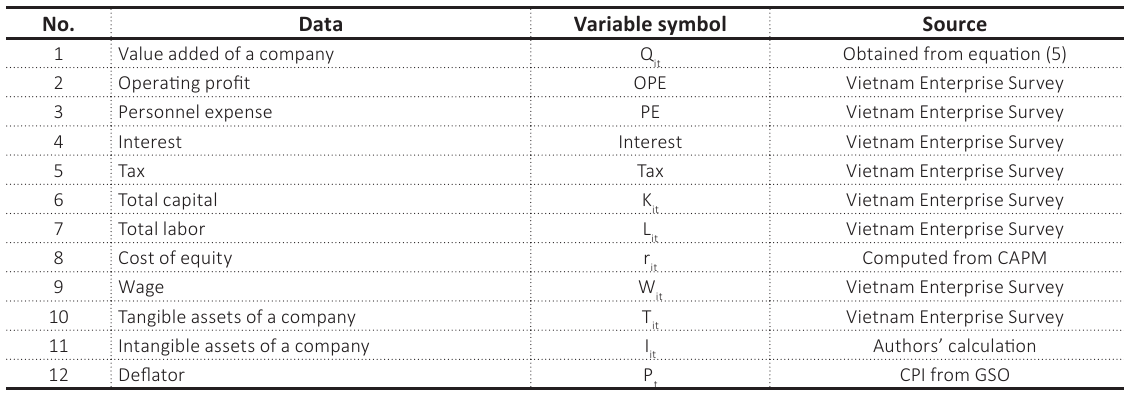
Source: Authors’ summary.